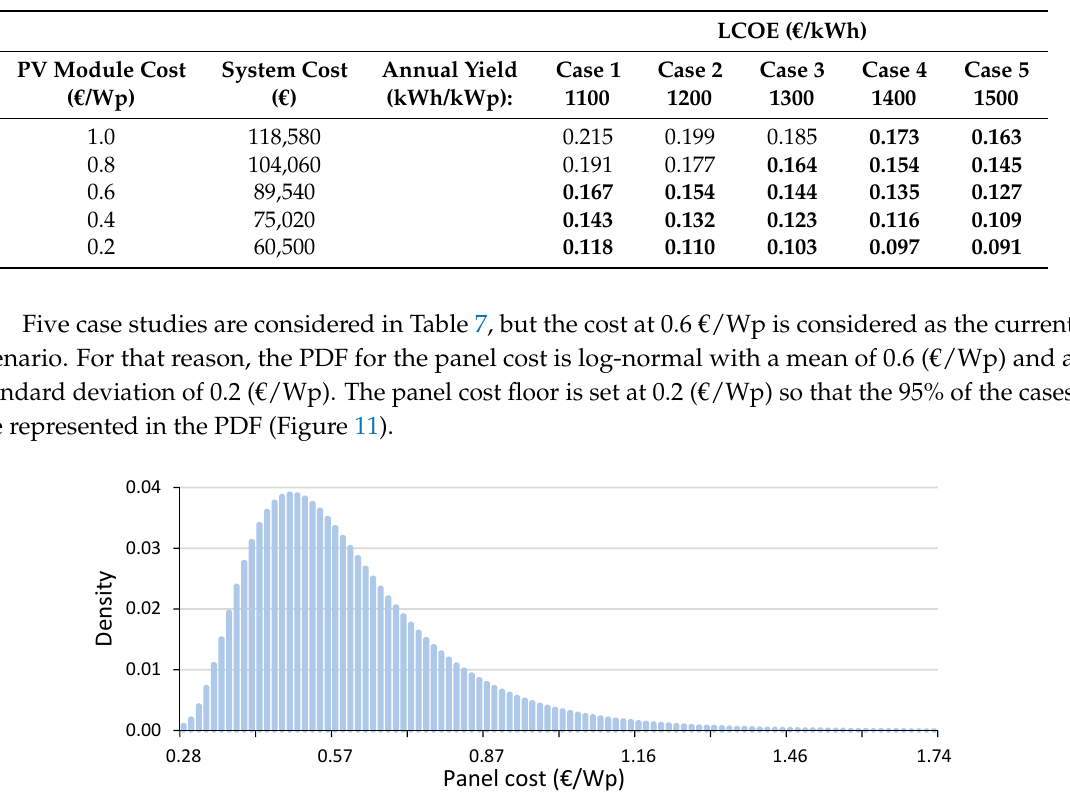
Table 10. Comparison of the LCOE based on the different annual yield for 50 kW.